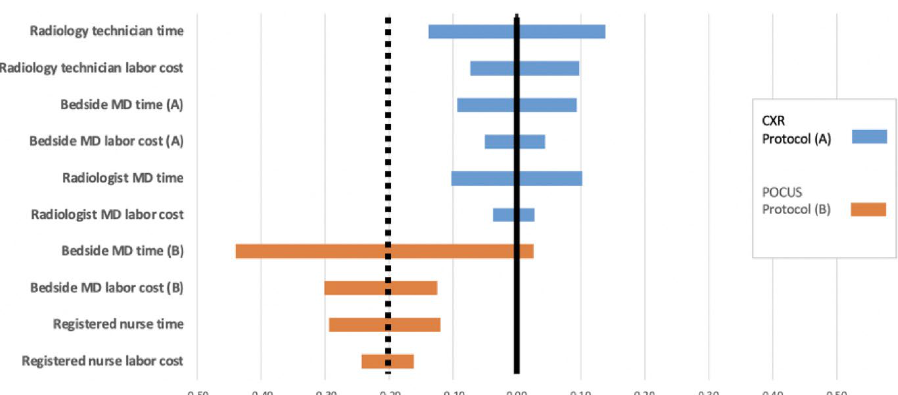
Figure 3. Tornado chart depicting percent change in total cost with variation in individual variables. Each bar depicts deviation in the total cost of a protocol that follows variation of an individual